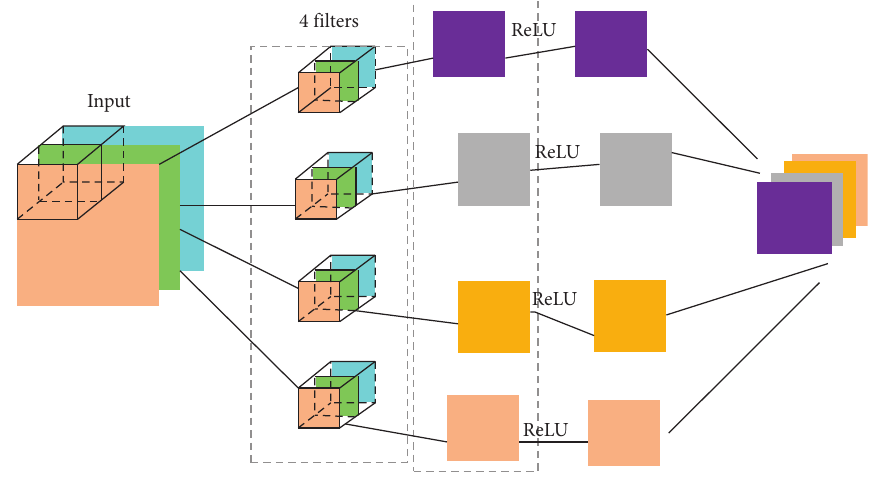
Figure 2: BP method